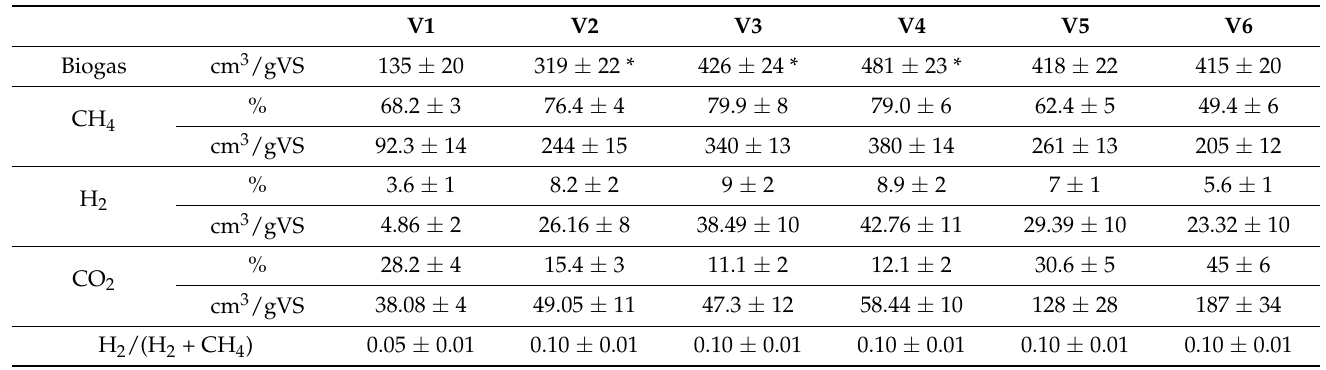
Table 2. Yields of biogas and its major fractions in particular technological